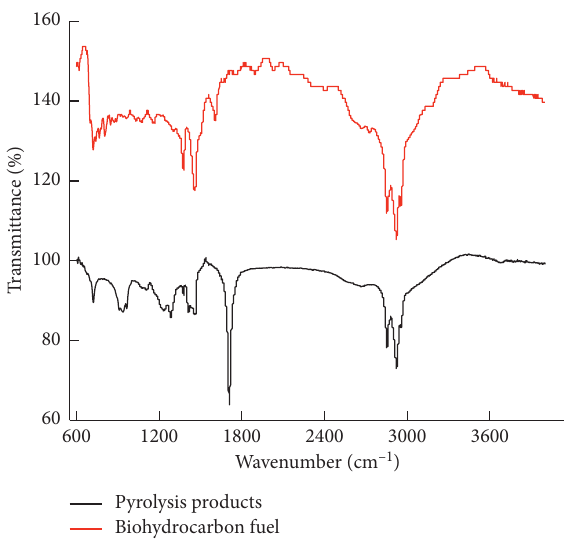
Figure 15: FT-IR spectra of pyrolysis products and biohydrocarbon fuel.